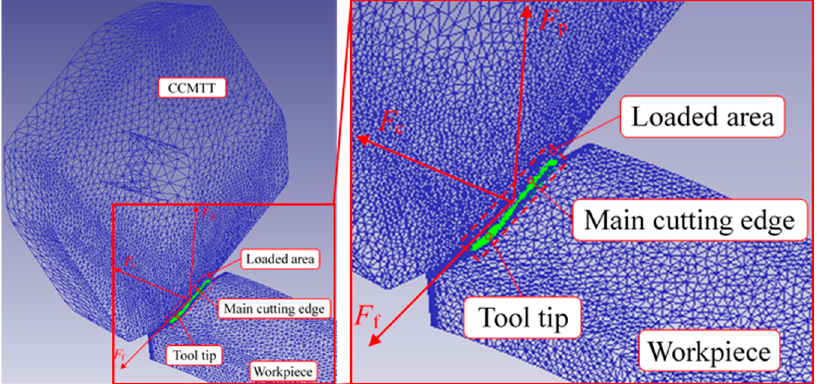
Figure 7. Loaded area of CCMTT in cutting simulation.